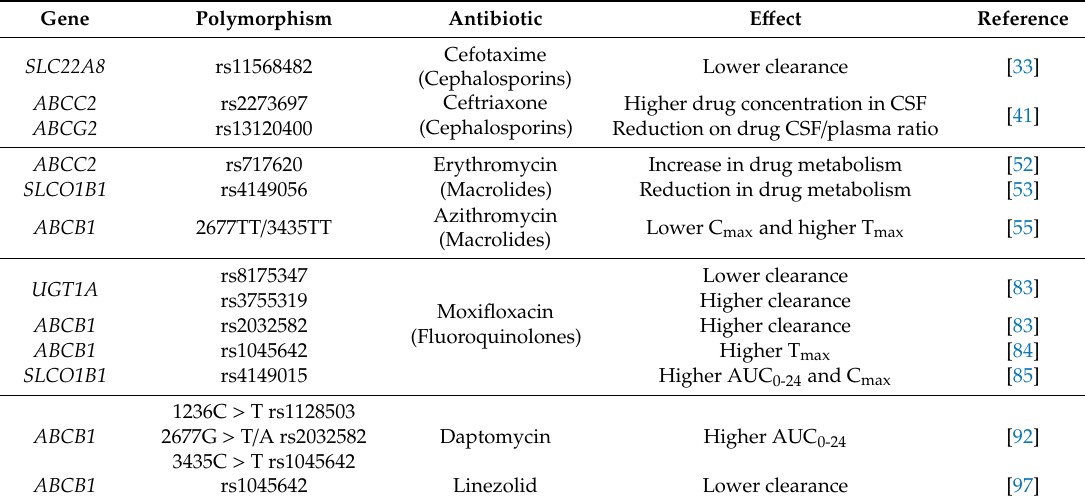
Table 1. Genetic association with genes related to antibiotic drug pharmacokinetics.